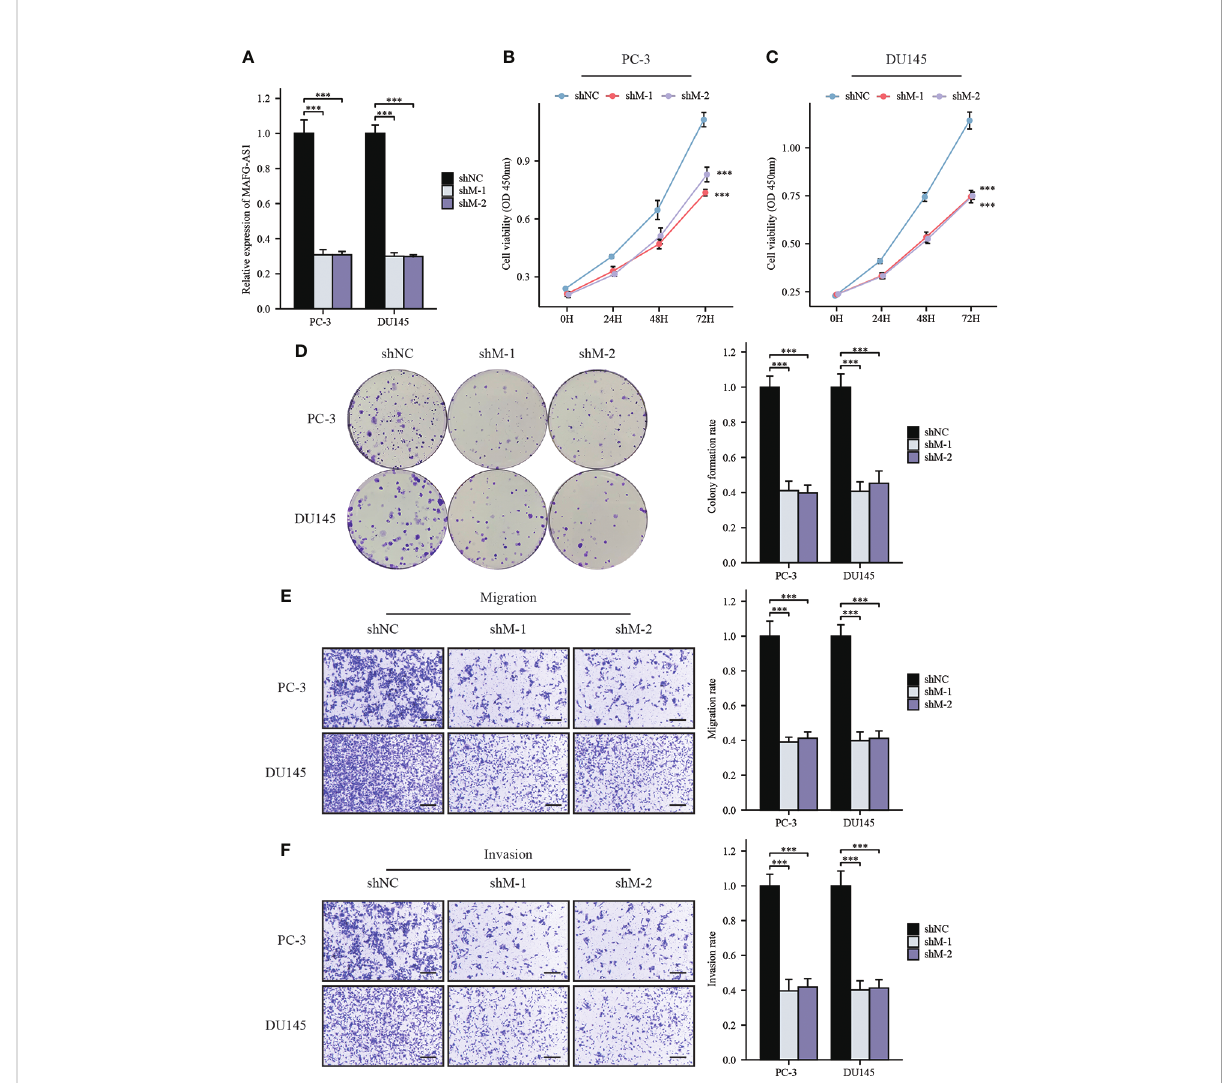
FIGURE 5 MAFG-AS1 knockdown signi fi cantly inhibited prostate cancer cell progression. (A) RT-qPCR analysis of MAFG-AS1 in MAFG-AS1 knockdown prostate cancer cells. (B, C) Downregulated MAFG-AS1 markedly inhibited cell viability of PC-3 and DU145 cells. (D) Knockdown of MAFG-AS1 impaired the ability of colony formation of PC-3 and DU145 cells. (E, F) The migration and invasion ability of PC-3 and DU145 cells were reduced following MAFG-AS1 knockdown (Scale bar: 50 m m). Data were indicated as mean ± standard deviation, ns P ≥ 0.05, * P < 0.05, ** P < 0.01, *** P <